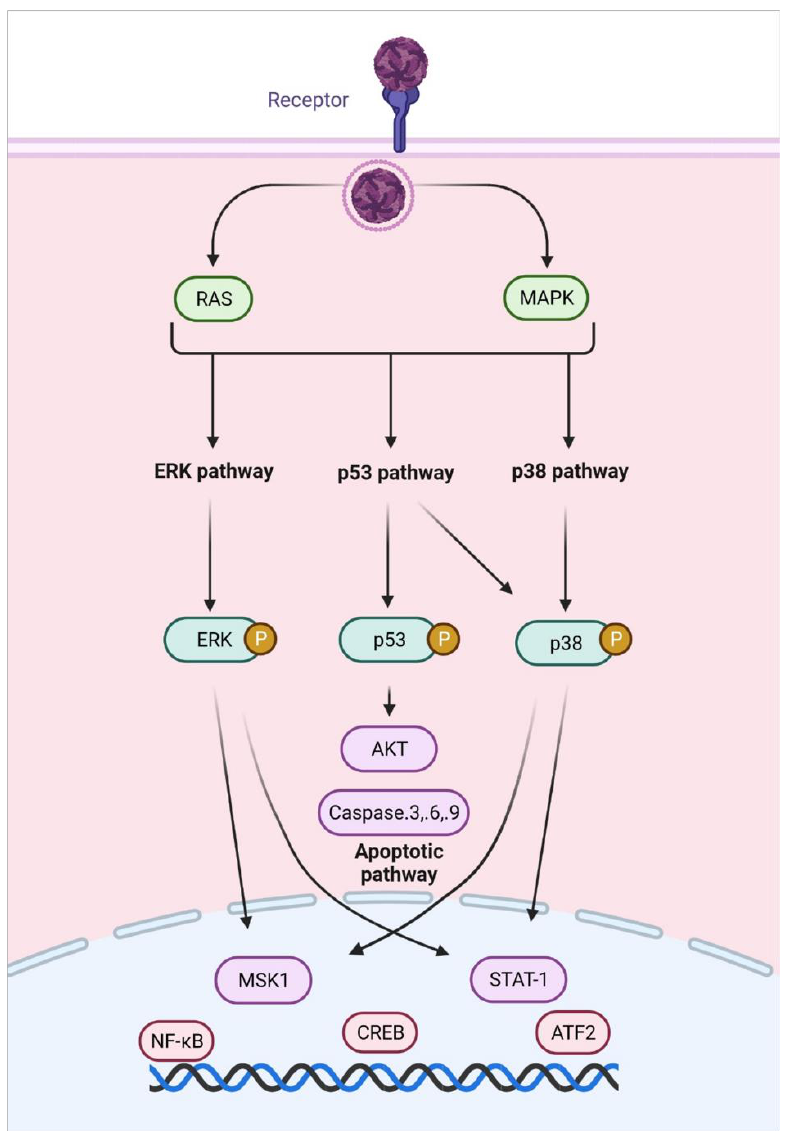
Figure 8. RVFV infection leads to the induction of ERK, p38, MAPK, and p53 phosphorylation . The activation of p53 escorts transcriptional upregulation of the apoptotic genes correlated with the in- creased levels of cleaved effector caspase -3, -6 and -9 and apoptotic pathways. Created with Bio- Render.com (Accessed on 13 September 2022).